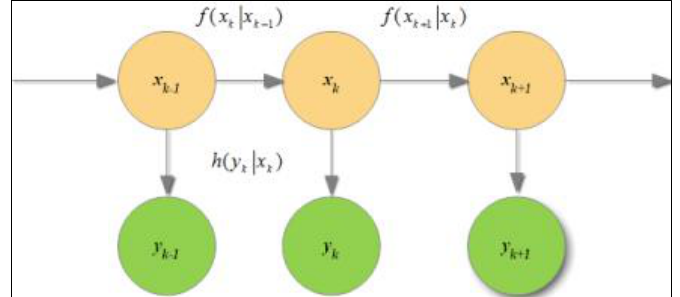
Figure 4. HMM showing the transition and observation